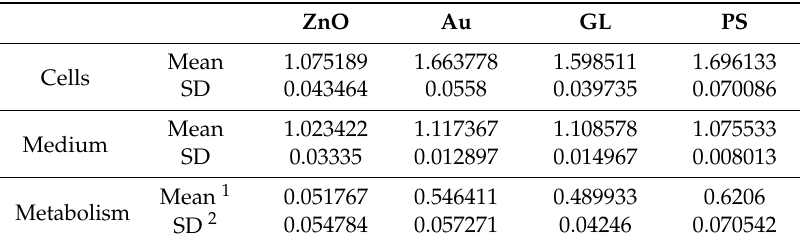
Figure 4. MTT assay of HL-1 cells showed the absorbance of material + HL-1 cells and material + medium, and the absorbance for the metabolism of HL-1 cells (data were presented as mean + standard deviation; standard deviation was shown as the plus direction of the error bar; +, Δ , and * represented a significant difference compared to the absorbance of Au-coated cover glasses (Au) + medium, uncoated cover glasses (GL) + medium, and cell culture-treated polystyrene multi-well culture plates (PS) + medium, respectively; Λ , ∇ , and ∴ represented a significant decrease compared to the metabolism levels of the cells cultured on Au, GL, and PS, respectively). Table 4. The absorbance of the MTT assay of HL-1 cells.